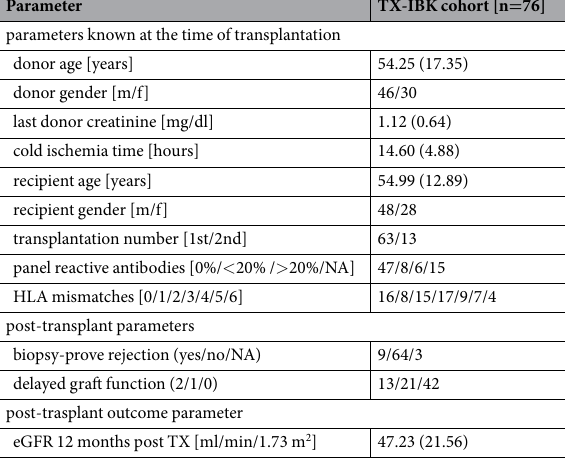
Table 2. Clinical characteristics of the TX-IBK cohort. Average values with standard deviations in brackets are given for the continuous clinical parameters donor age, last donor creatinine, cold ischemic time, recipient age, and eGFR 12 months post TX. Counts are given for the categorical variables donor gender, recipient gender, transplantation number, panel reactive antibodies, and sum of HLA mismatches as well as for the post-trasnplant parameters biopsy-proven rejection and degree of delayed graft function (2 = severe, 1 = mild, 0 =